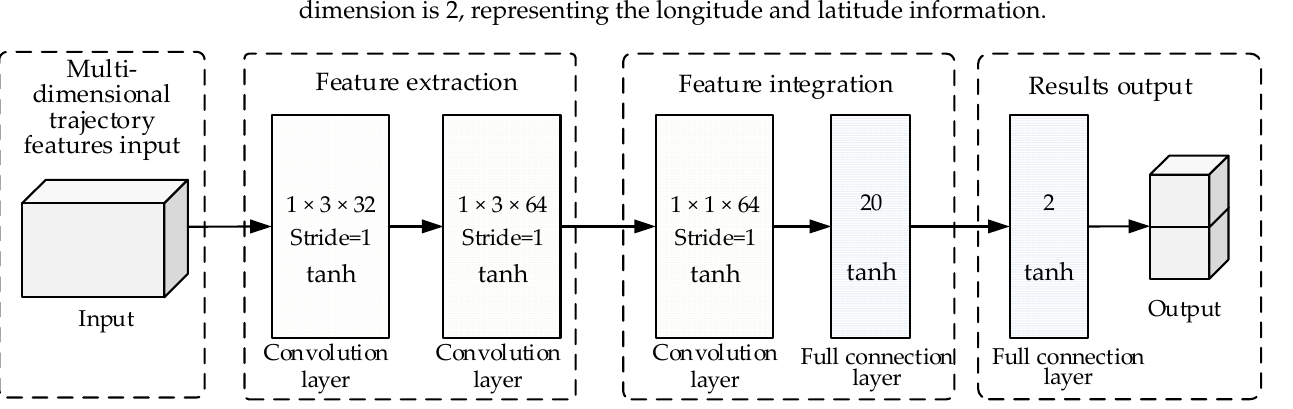
Figure 2. The architecture of the network.